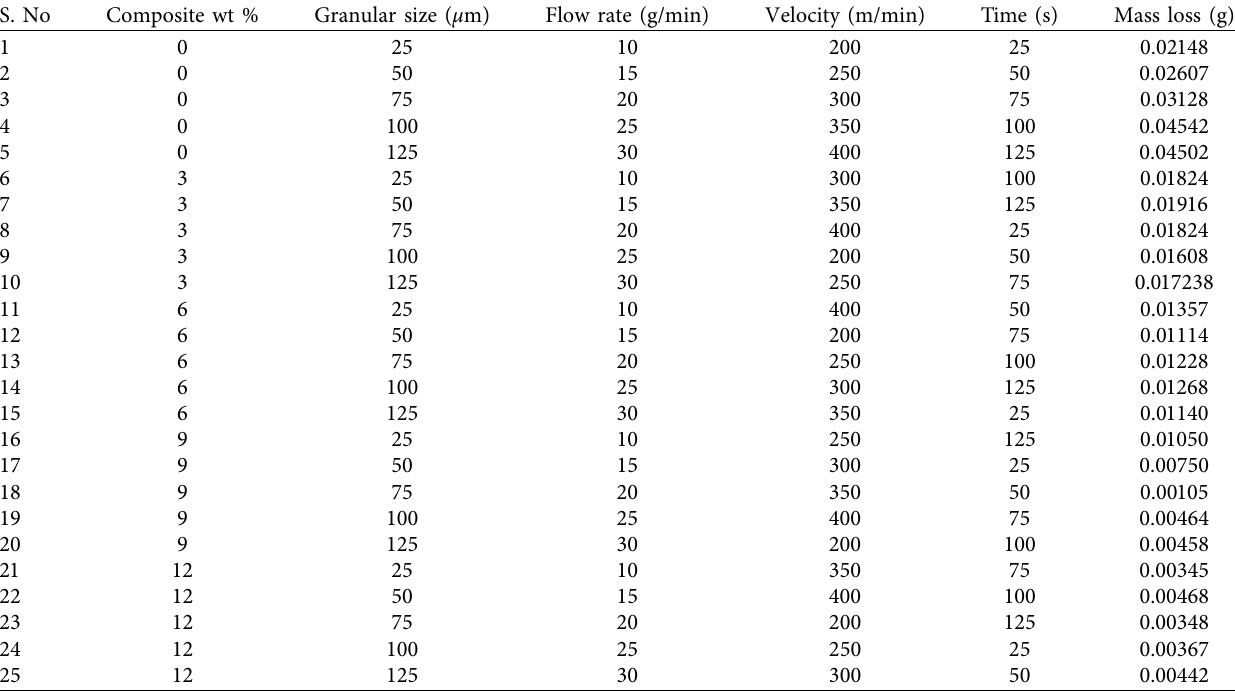
Table 5: With L 25 orthogonal array, the input and output factors of abrasive wear.